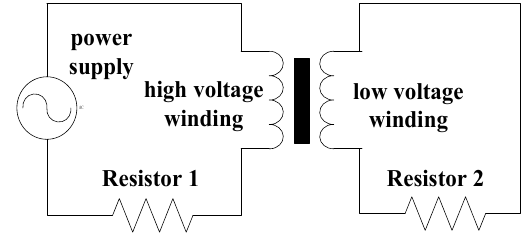
Figure 6. External-circuit equivalent diagram.